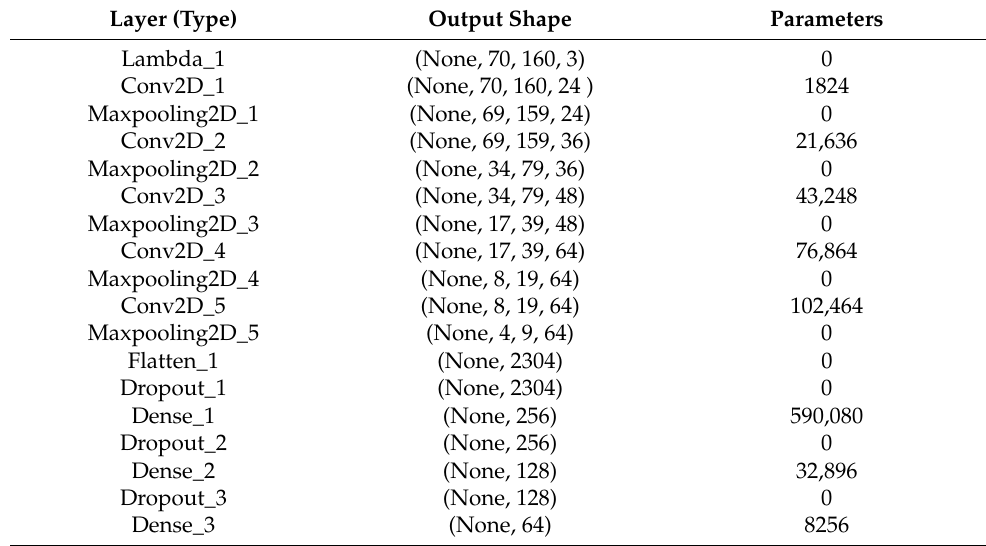
Table 1. Network architecture for camera